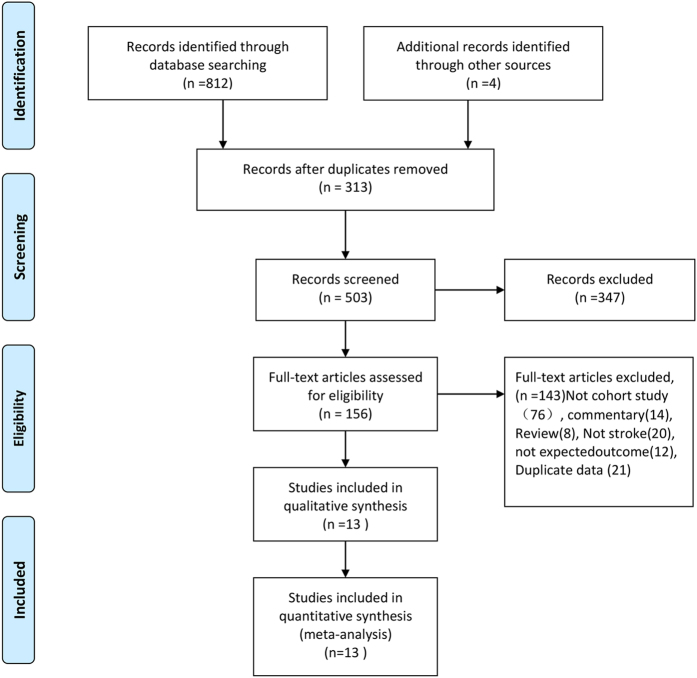
The process of study selection.